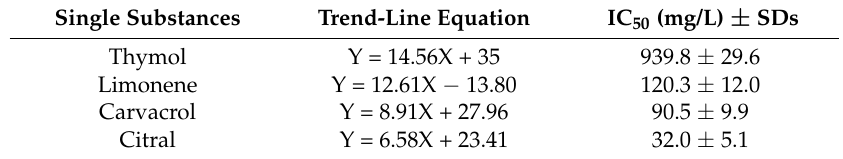
Table 3. Evaluation of cytotoxicity of main single constituents of oregano EO against healthy renal cells. Single Substances Trend-Line